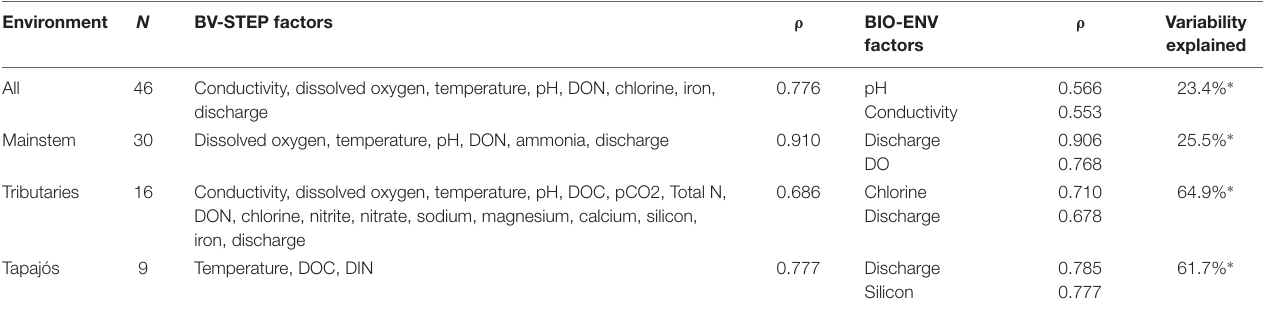
TABLE 1 | Spearman Rank coefficients ( ρ ) showing correlations between environmental data and bacterial community composition for all river samples, and samples grouped by location in the mainstem Amazon River (Macapá North, Macapá South, and Óbidos), tributaries (Tapajós and Belém), and the Tapajós tributary alone.